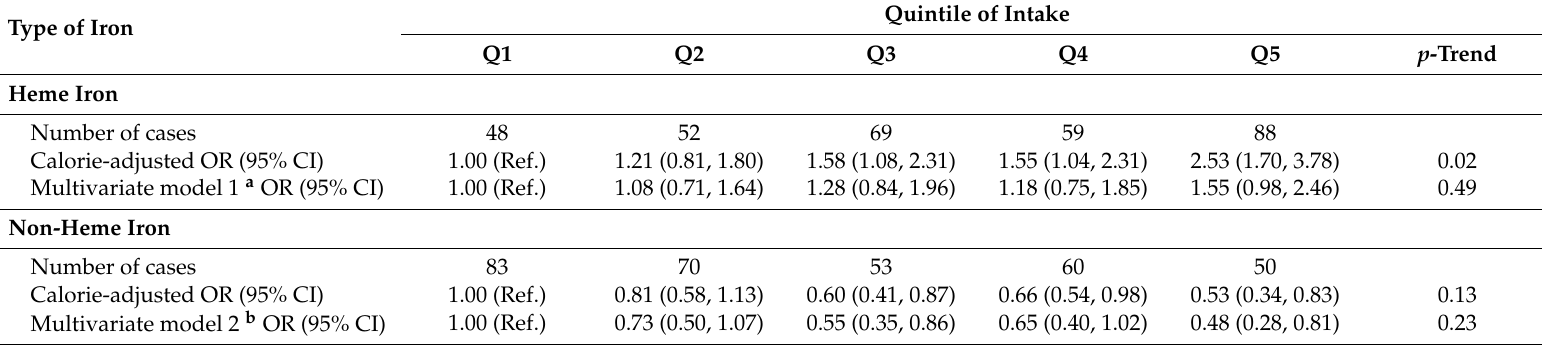
Table 2. Calorie-adjusted and multivariate ORs for GDM ( n = 316) by preconceptional dietary, heme and non-heme iron intake ( n = 7229).